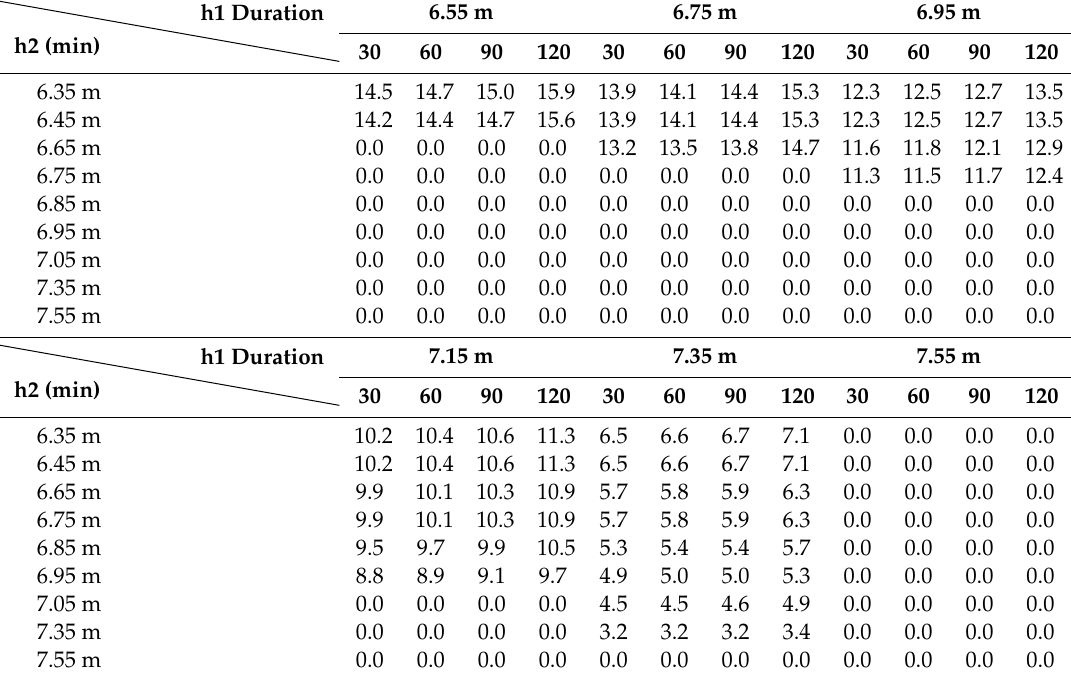
Table 6. Rainfall depth according to duration for caution warning criteria (unit: